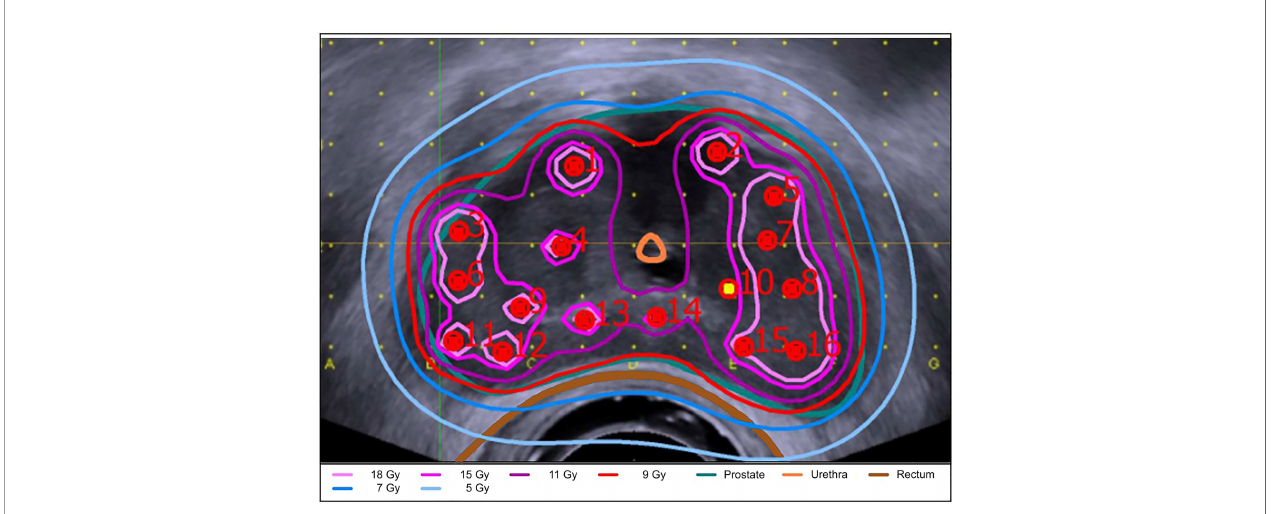
FIGURE 2 | 3D TRUS-supported intraoperative radiation planning. Shown is the 3D TRUS-supported intraoperative radiation planning using the SagiPlan treatment planning system (Eckert & Ziegler BEBIG GmbH). The prostate (turquoise), rectum (brown), intraprostatic urethra (orange) and the isodose distribution are shown in an axial view. The isodose distribution is coded with the following colours: light pink = 18 Gy (D 180% ); pink = 15 Gy (D 150% ); purple = 11.0 Gy (D 110% ); red = 9 Gy (D ref ); blue = 7 Gy (D 70% ); light blue= 5 Gy (D 50%